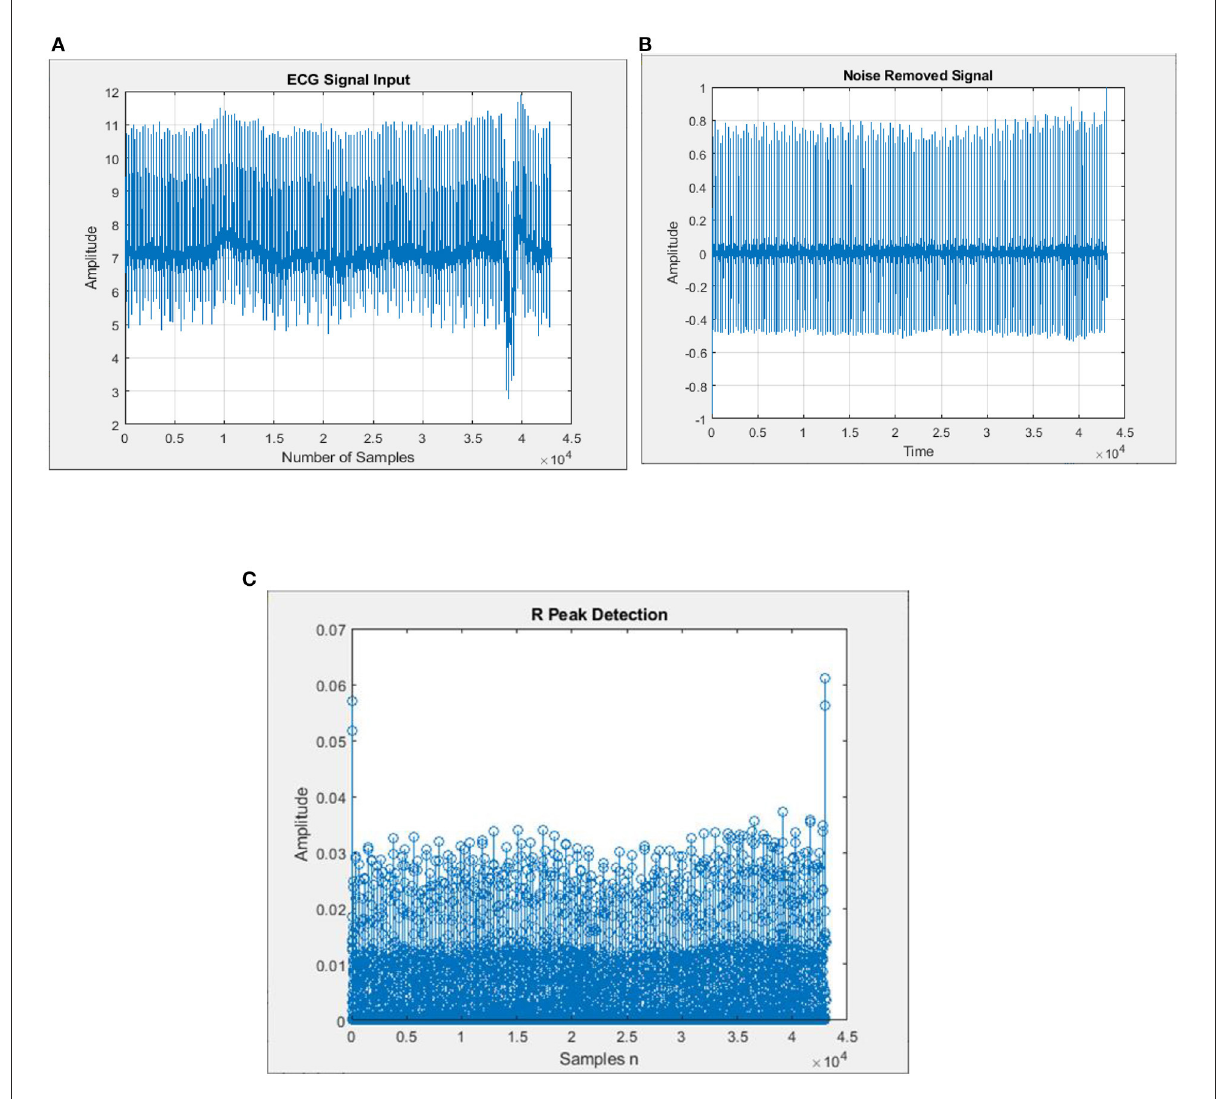
PDA PDAs are considered the edge devices like smartphones. Smartphones have more computational power than their local counterparts. A spectrogram is a two-dimensional representation of ECG generated by a discrete wavelet transform. RNN is used to categorize the Spectrogram. PDA will identify if the ECG signals are of a standard or abnormal rhythm. When an edge device detects something out of the ordinary, it immediately notifies the central server in the cloud and fog. After the noise reduction stage, the discrete wavelet transform